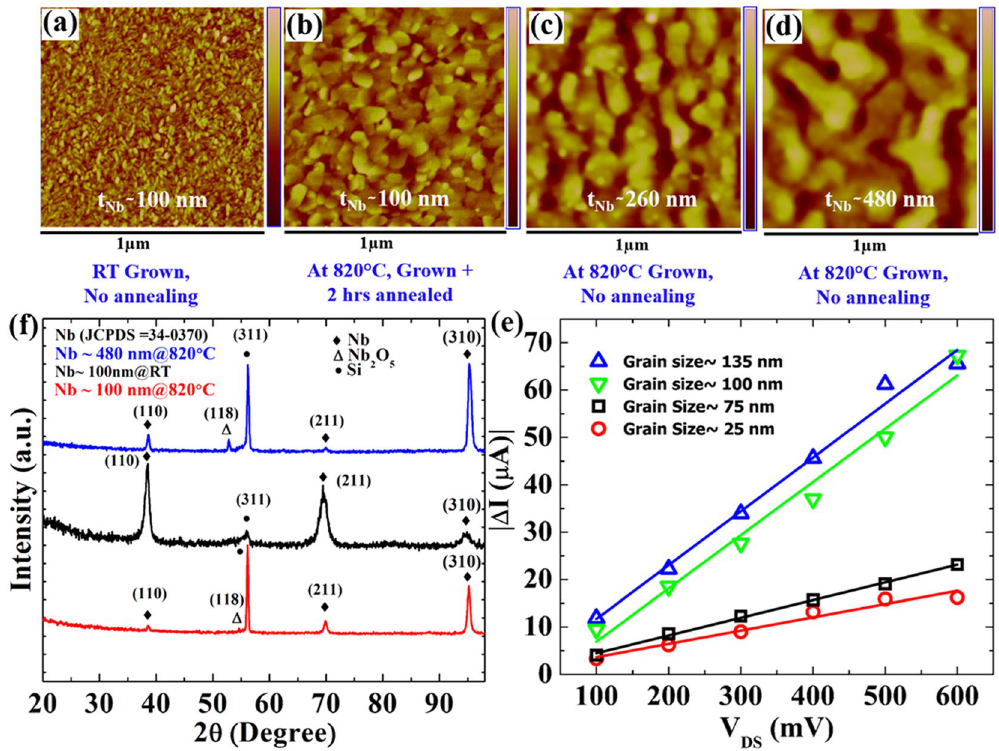
Figure 3. Morphological and structural analysis of NNFs having variations in the grain sizes and thicknesses and their dependence on the measured change-in-current ( Δ I ). ( a–d ) AFM topography images representing the variations in the grain sizes for differently grown NNFs. The size varies in the range between 20 nm–140 nm. The colour bars represent the height variations of 0–6.6 nm, 0–9.4 nm, 0–12 nm, and 0–18 nm for ( a ), ( b ), ( c ), and ( d ) respectively. ( e ) Bias dependent change-in-current ( Δ I ) for the presented 4 samples along with their linear fits shown by the solid lines. ( f ) HRXRD spectra of 3 out of the 4 reference samples. The oxide phases of niobium appear for the high temperature grown